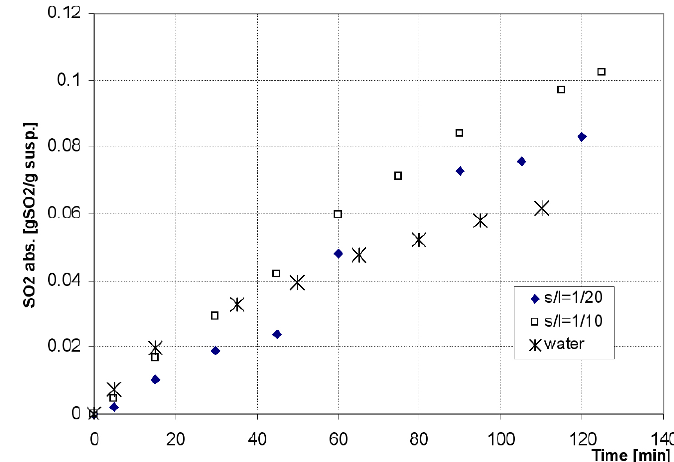
Figure 7. Kinetic data in sulfur dioxide absorption in CCP slurry with dp=0.25 mm and T=298